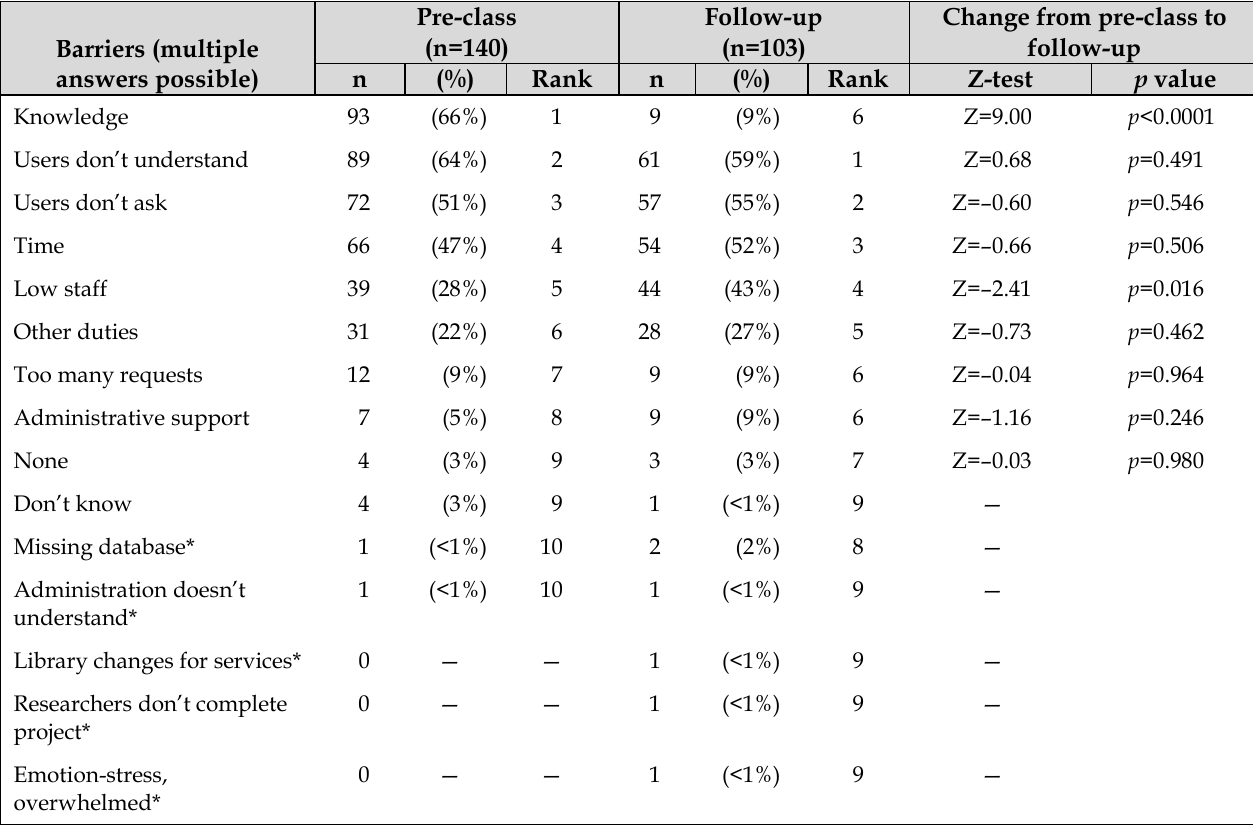
Table 3 What barriers, if any, have you encountered to being involved in systematic review